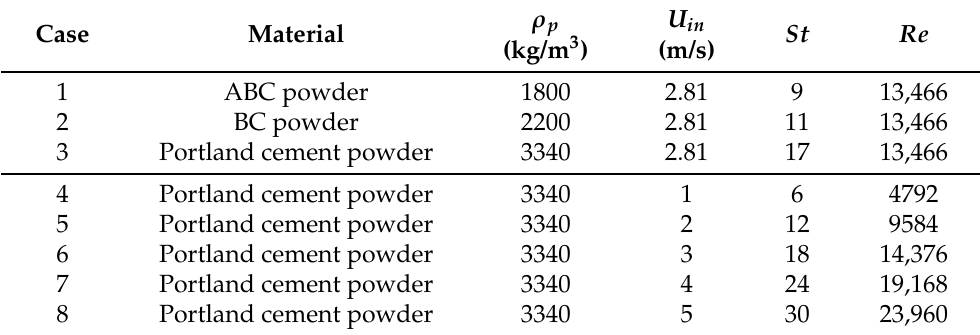
Table 1. Parameters of simulation cases performed in this